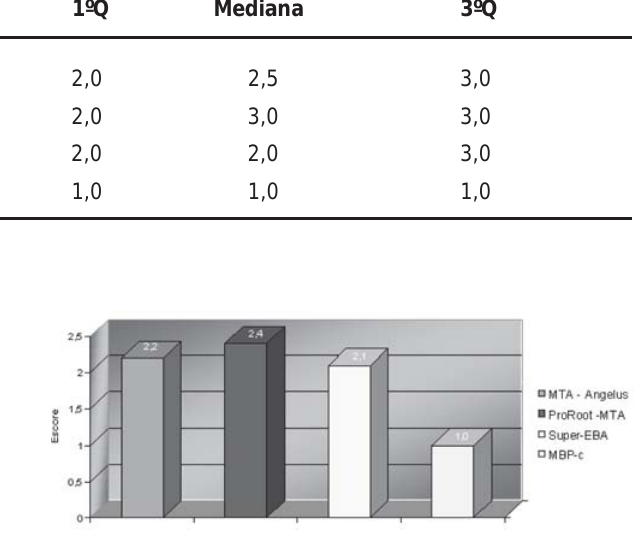
FIGURA 2 - Gráfico representativo das médias dos escores das infiltrações marginais permitidas pelos cimentos testados. ( com matriz de gesso Paris